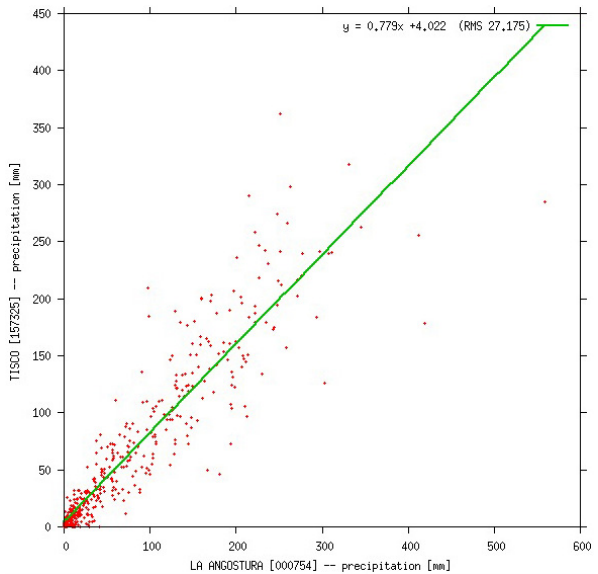
Figure 5. XY-plot for the two high-altitude precipitation sta- tions La Angostura (15.18 ◦ S, 71.65 ◦ W, 4150ma.s.l.) and Tisco (15.35 ◦ S, 71.45 ◦ W, 4175ma.s.l.). Shown are monthly precipita- tion sums (red crosses), the equation of the line of best fit (green line) and the RMS value.